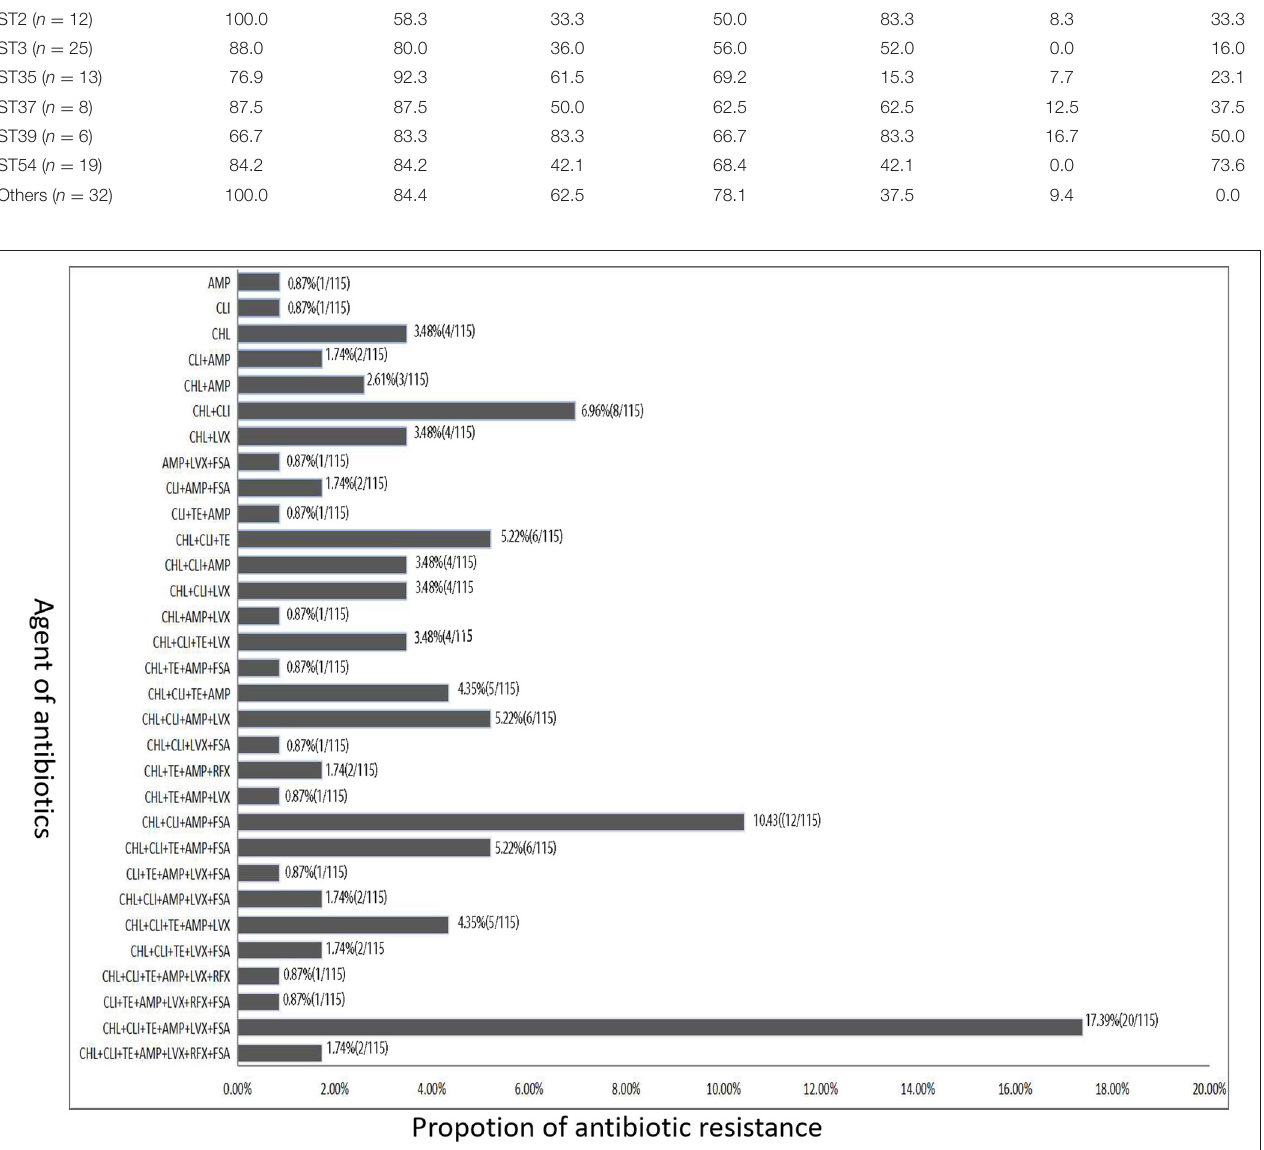
increased incidence rate might be related to the